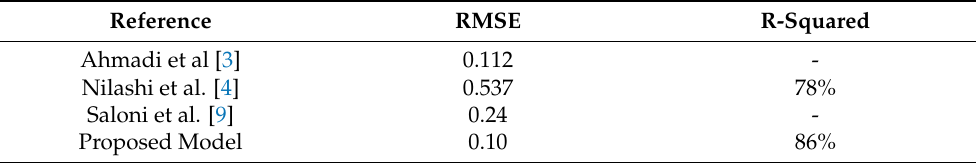
Table 2. Proposed method results comparison with existing